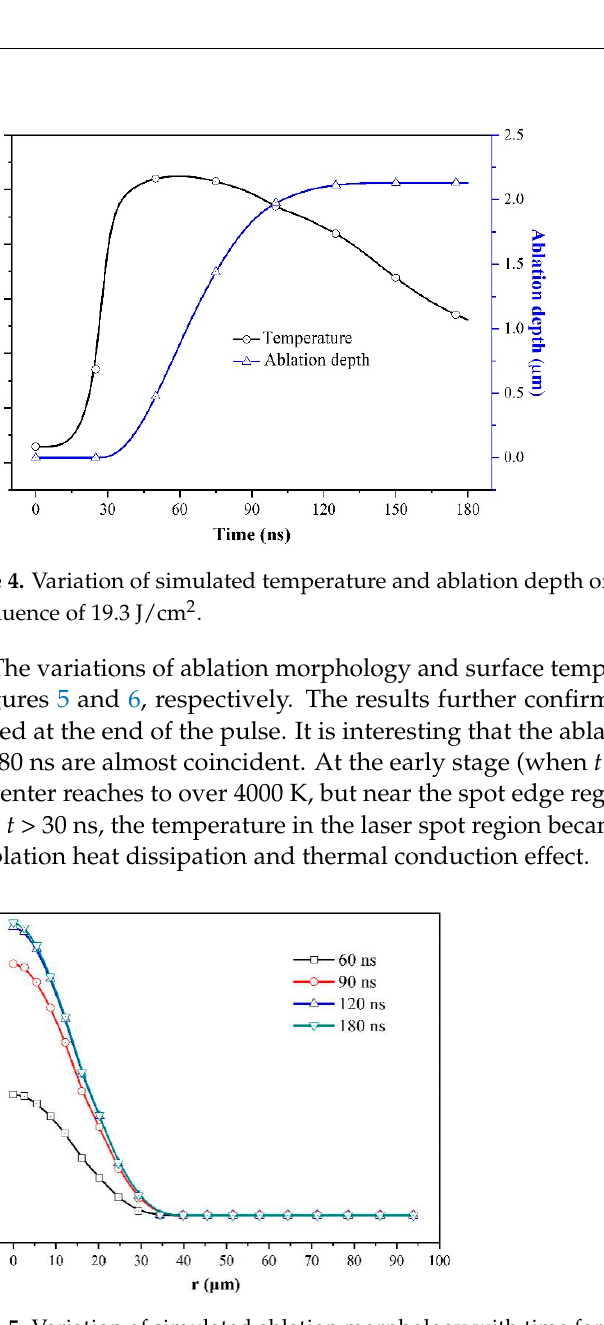
Figure 5. Variation of simulated ablation morphology with time for laser fluence of 19.3 J/cm 2 .